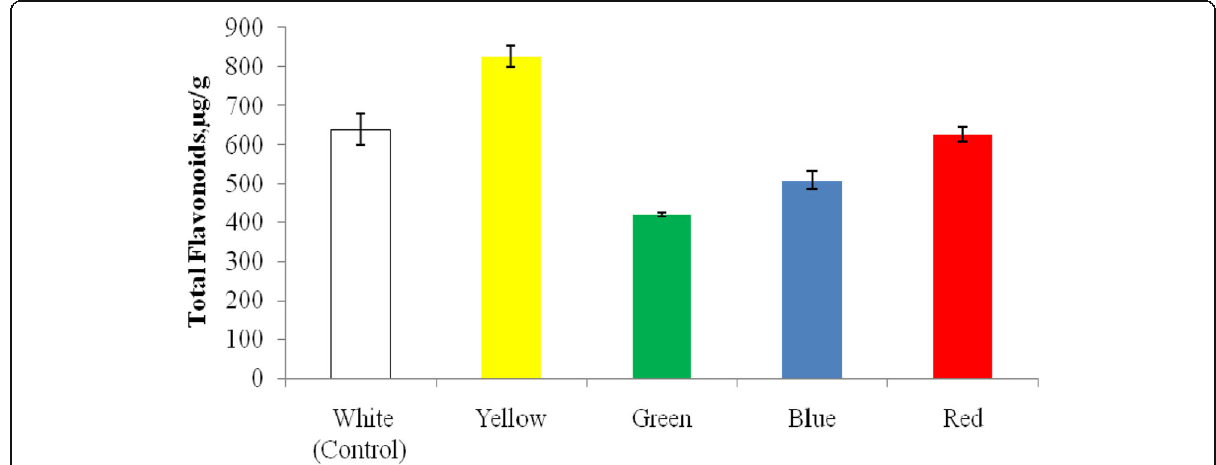
Fig. 3 DPPH free radical scavenging (%) under different light qualities. Values presented means ± standard error from